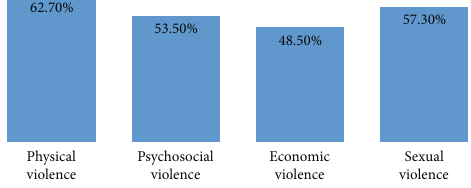
Figure 3: Lifetime prevalence of IPV during pregnancy.